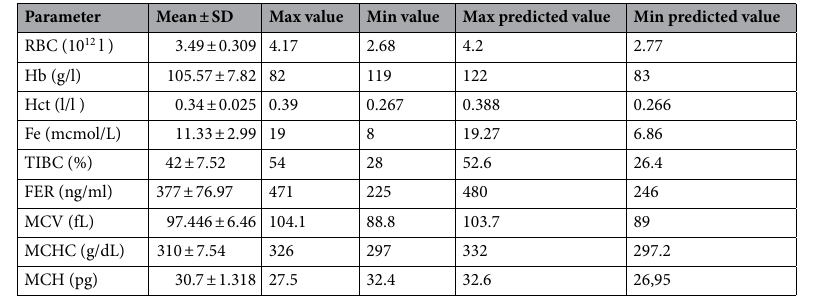
Table 1. Composition of biological analytes used in this